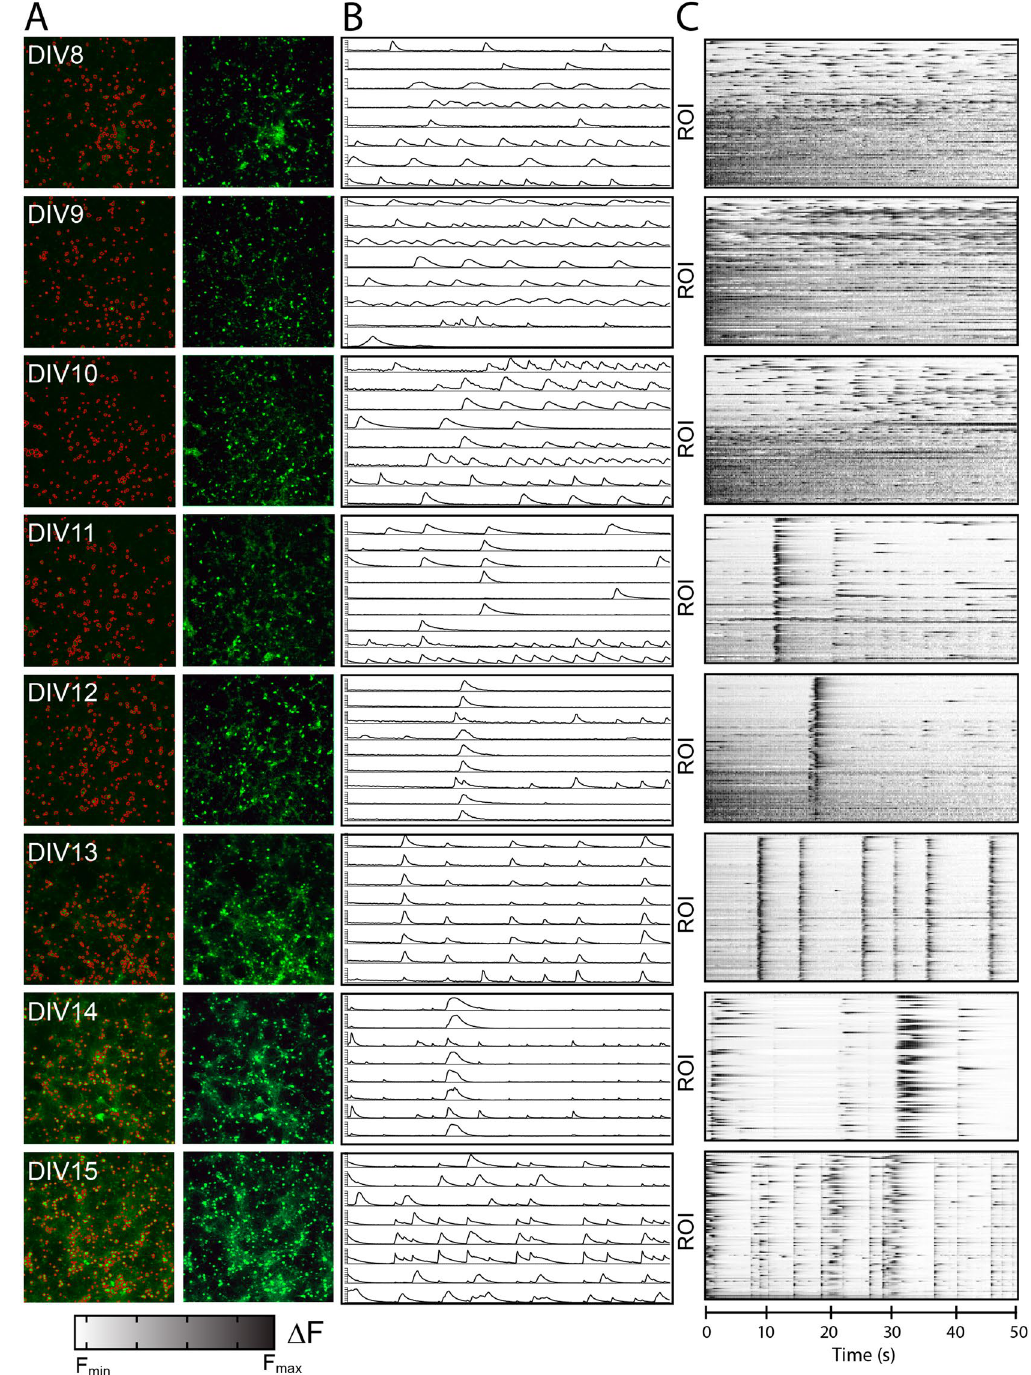
Figure 2. Automated multi-neuron tracking of calcium transients during maturation of neuronal cultures. ( A ) Representative maximum intensity projections of neurons at DIV8–DIV15 with (left) or without (right) ROI overlays (shown in red). Images on right are leveled. ( B ) Representative calcium traces for 8 individual neurons are shown for each time point. ( C ) Representative raster plots show Δ fluorescence traces in the 100 most active ROIs within the optical field for frames 1–250. Data are representative of 4 independent experiments and > 50,000 total